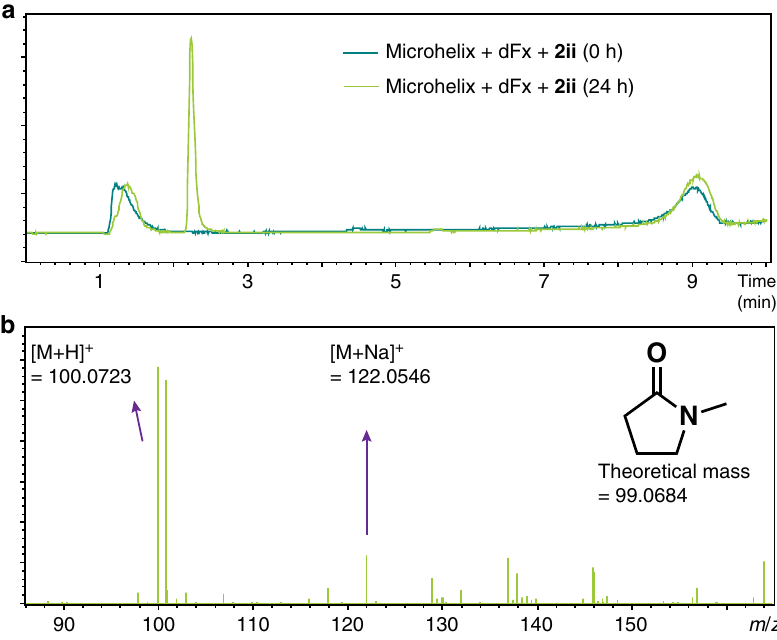
Fig. 3 Observation of lactam in Fx-mediated acylation of γ -amino acid. The lactam produced (light green) in the Fx-mediated acylation of substrate 2ii is observed. The extracted ion chromatogram a for the mixture of Fx reaction incubated for 24 h on ice showed a new peak corresponding to a theoretical mass of a lactam b . Data are representative of three independent